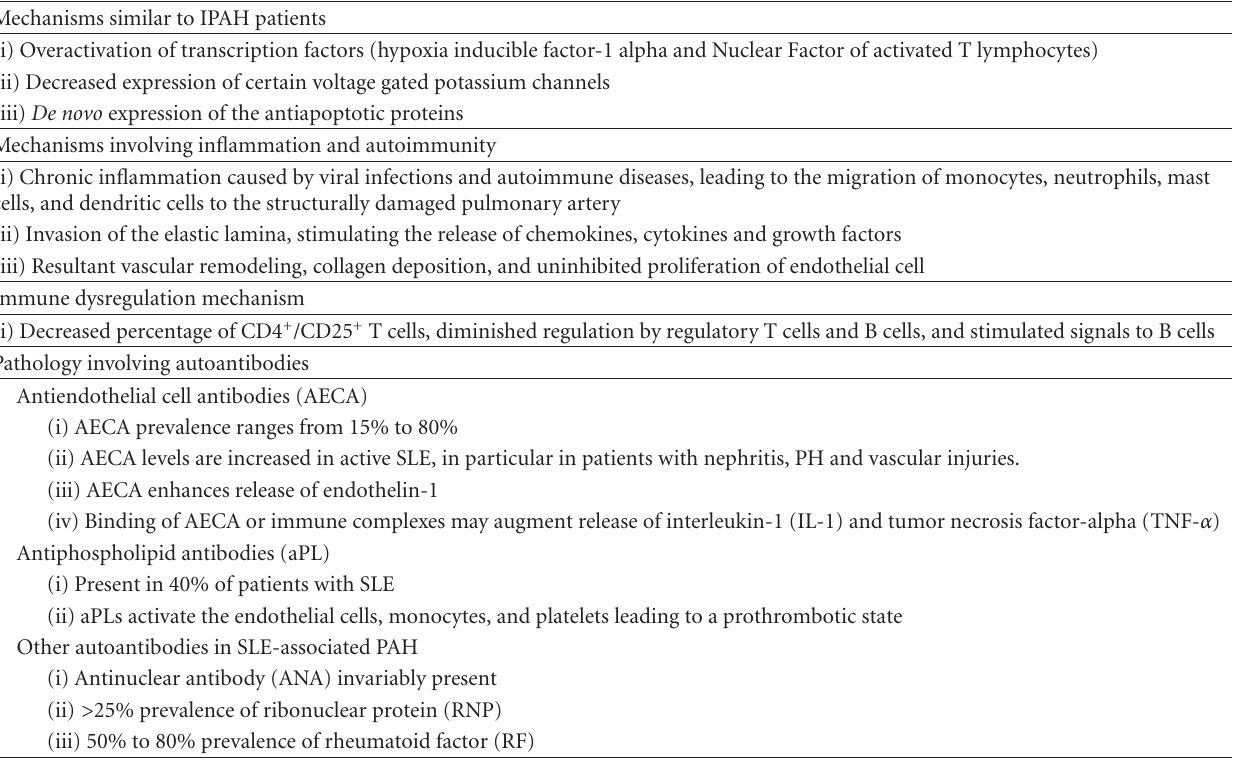
Table 3: Key causative mechanisms of PAH in systemic lupus